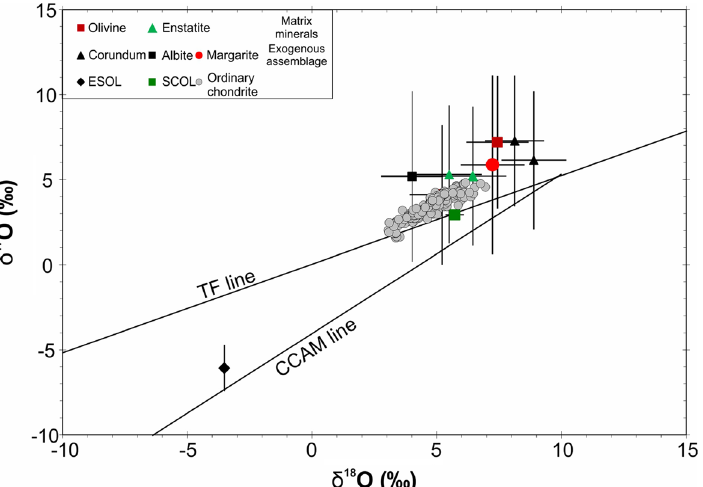
Figure 8. Triple oxygen isotope ratio diagram with the reference lines CCAM (Carbonaceous Chondrite Anhydrous Minerals, slope 1) and TF (Terrestrial Fractionation, slope 0.5) 54,55 , data for terrestrial and meteoritic standards ( SCOL San Carlos Olivine, terrestrial, ESOL Eagle Station Olivine, a pallasite meteorite), and data from the Kakowa groundmass (olivine and enstatite) and the Kakowa exogenous fracture fill (corundum, albite, margarite). Data for ordinary chondrites are also plotted 56 . Error bars are 2σ. Δ 17 O is the vertical distance of a point from the TF line in this